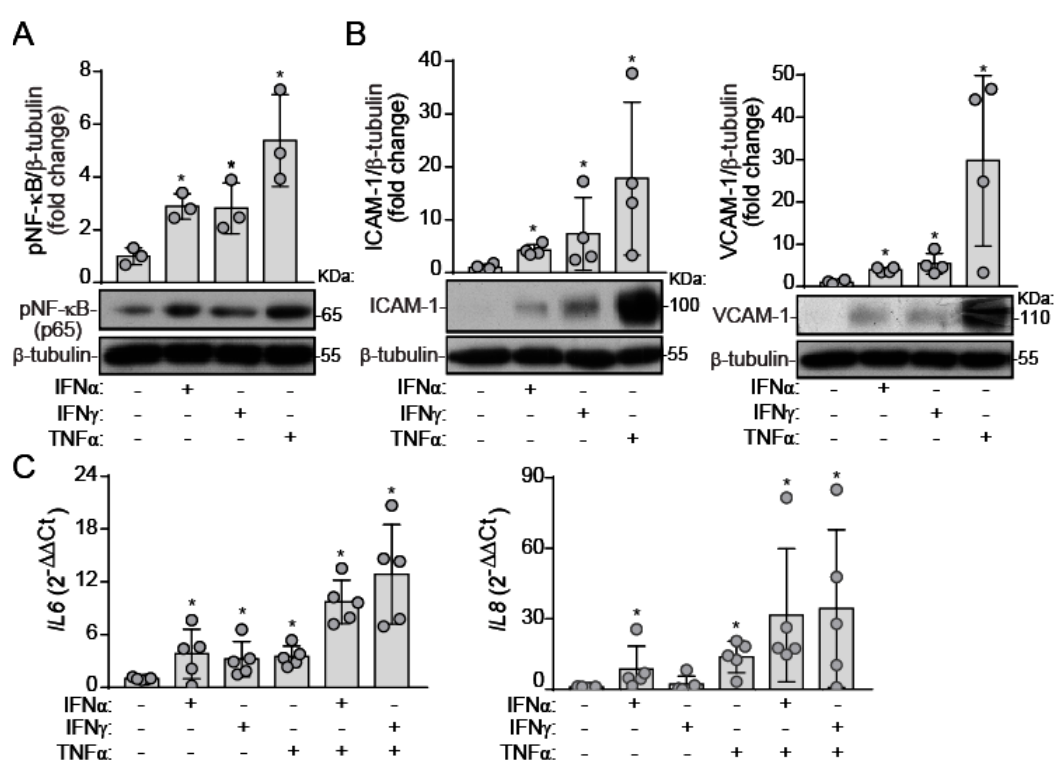
Figure 2. Interferons act as pro-inflammatory cytokines in VEC. ( A – C ) VEC monolayers were challenged with the indicated ligands under static conditions for 24 h. ( A , B ) Cell lysates were analyzed by Western blot to assess NF- κ B activation ( A ) and adhesion molecule expression, ICAM-1 and VCAM-1 (B); n = 4. ( C ) qPCR analysis of IL6 and IL8 gene expression; n = 5. Doses as in Figure 1. Datasets A–C: Mean ± S.D. One-Way ANOVA statistics, followed by the Dunnett post-hoc test. * p < 0.05 compared to the control group.